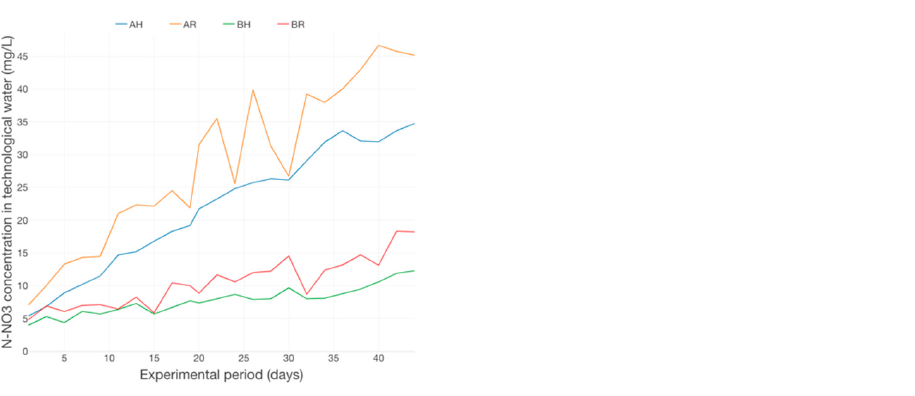
Figure 19. The dynamics of N-NO 3 concentration in technological water for each of the experimental variants.